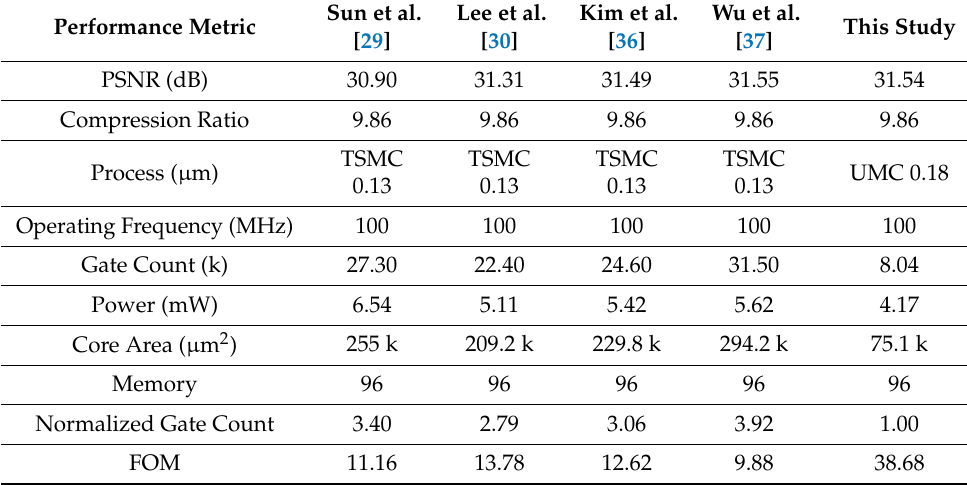
Sun et al. Lee et al. Kim et al. Wu et al. This Study [29] [30] [36] [37]